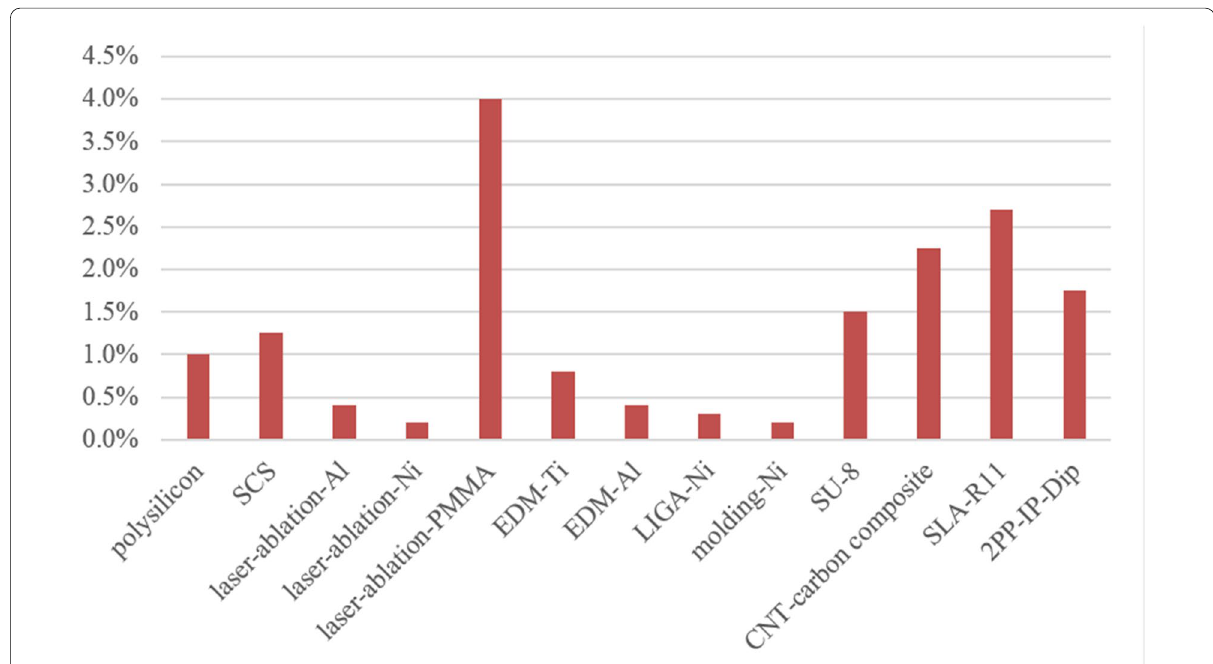
Figure 14 Column chart of the maximum allowable strain of the 13 process-material